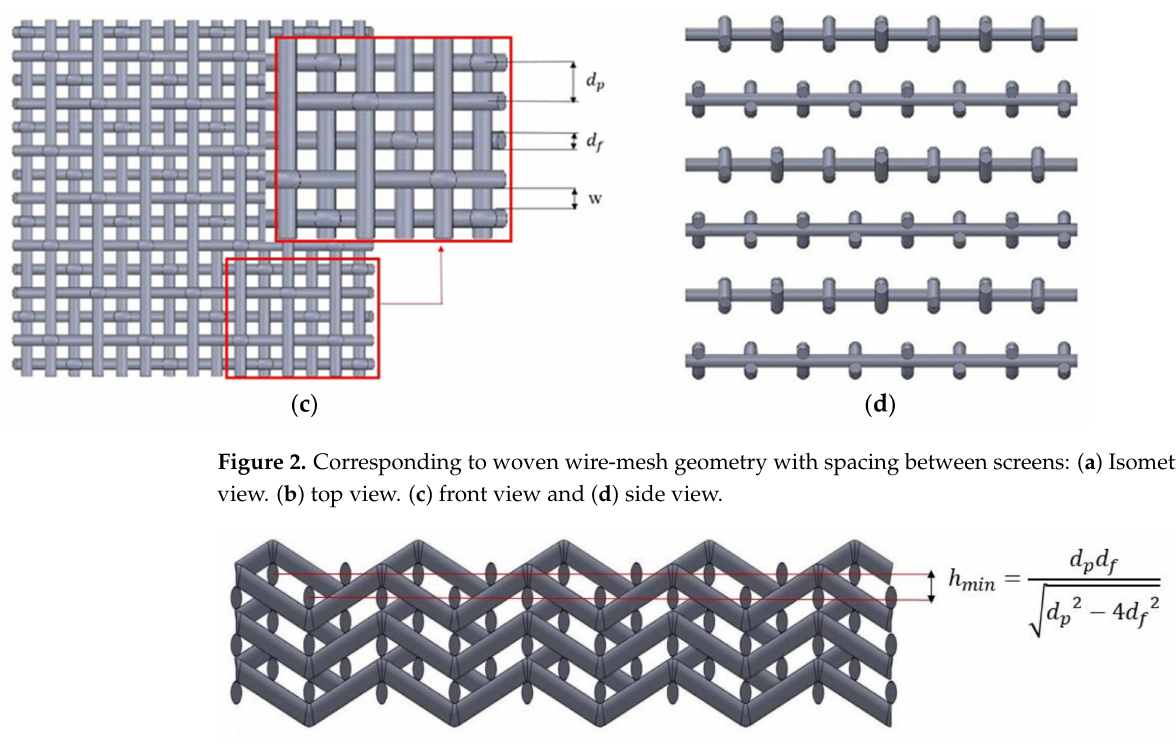
Figure 3. Front view of staggered stacking for closely packed scenario (with h min spacing).